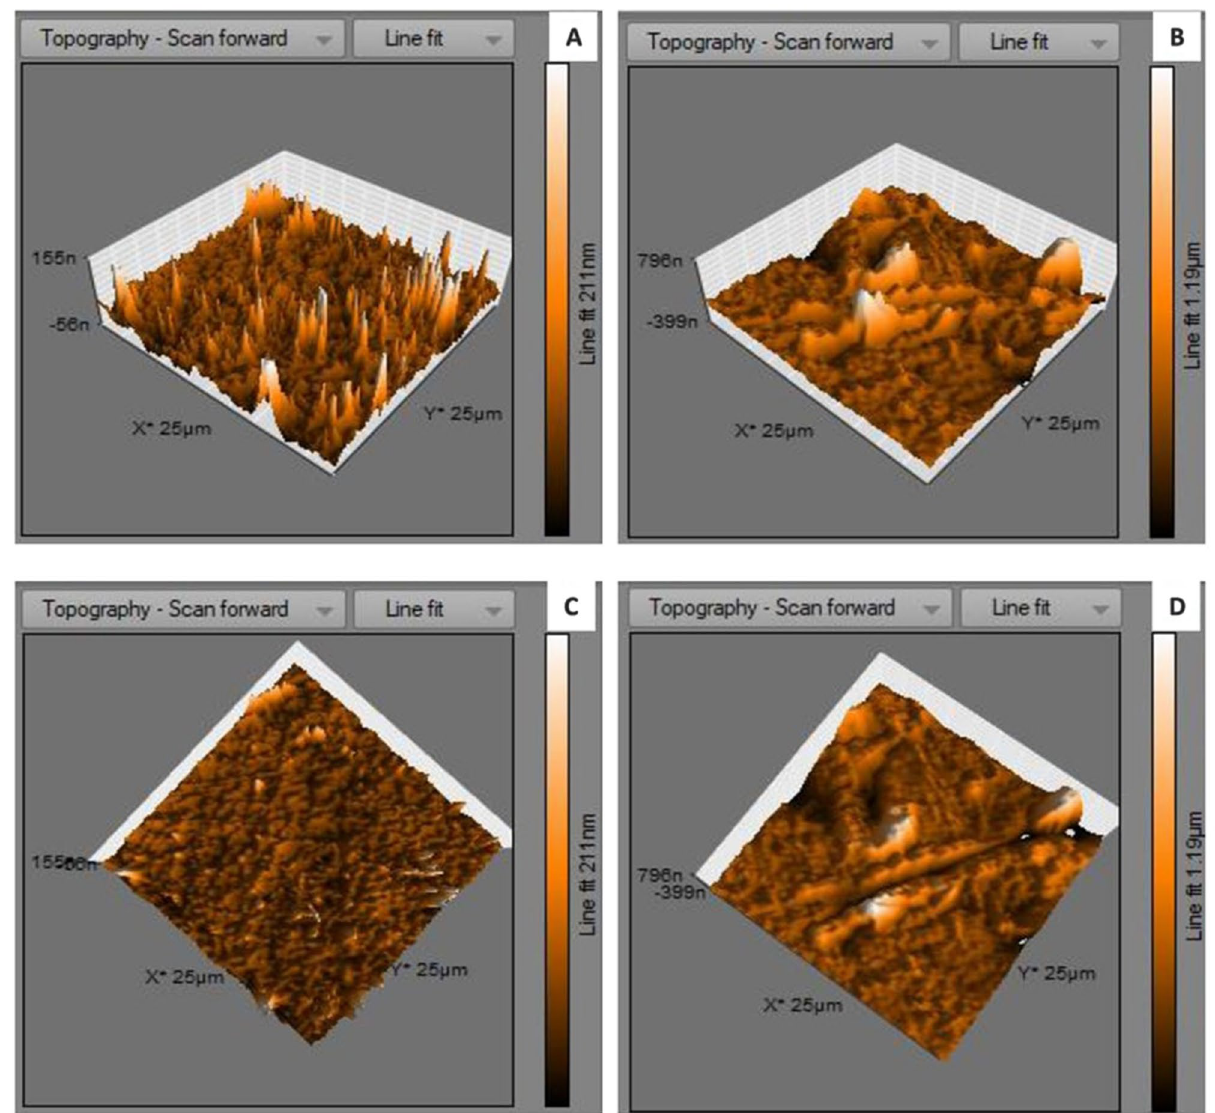
Figure 29. ( A ) Three-dimensional view of control (untreated) LDPE sheet of 25 µm 2 area; ( B ) Three- dimensional view of U. africanum treated LDPE sheet; ( C ) Topographical view of control (untreated) LDPE sheet; ( D ) Topographical view of U. africanum LDPE sheet with erosions, grooves and ridges on its